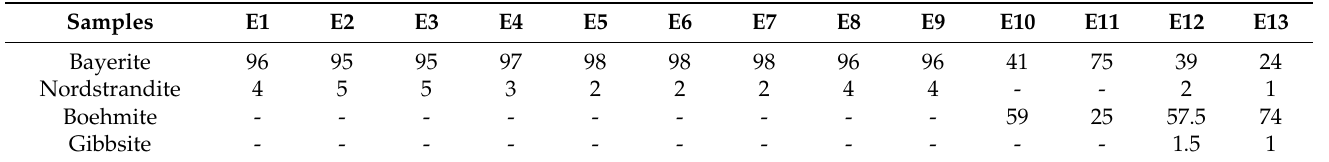
Table 5. XRD results (wt%).